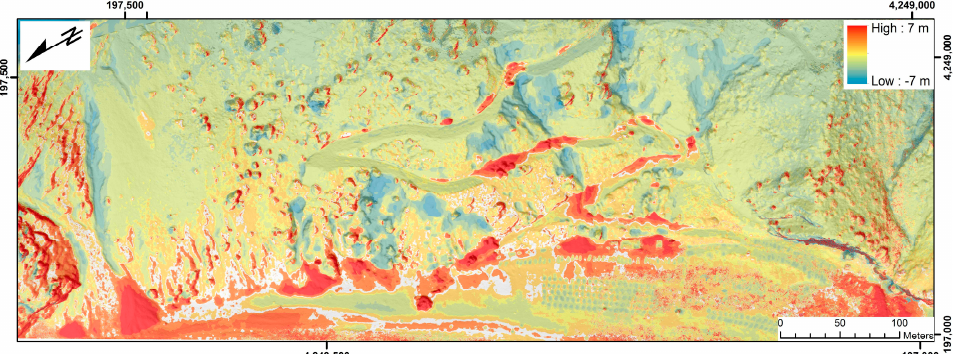
Figure 11. The results of the processing of the affected area over Myrtos beach with the DoD technique. The color scale shows the calculated vertical changes. Blue areas show elevation loss (erosion) and therefore the sources of material, whereas red areas of the figure show elevation gain (deposition), which in many locations exceeds a thickness of 5 m.